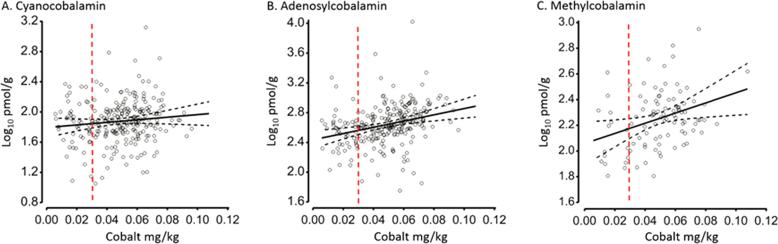
Relationship between elemental cobalt (mg/kg fresh weight) and B12 vitamers (log10 pmol/g fresh weight) in sheep liver. Outputs generated using multiple regression models adjusted for farm of origin. In contrast to cyanocobalamin (A), liver concentrations of which were not related to cobalt, both liver adenosylcobalamin (B) and methylcobalamin (C) increased (P < 0.001) with cobalt. Red dotted lines represent the lower marginal threshold for liver cobalt concentrations in sheep; below which animals, over time, exhibit signs of clinical B12 deficiency [42]. Black dotted lines represent 95% confidence intervals.